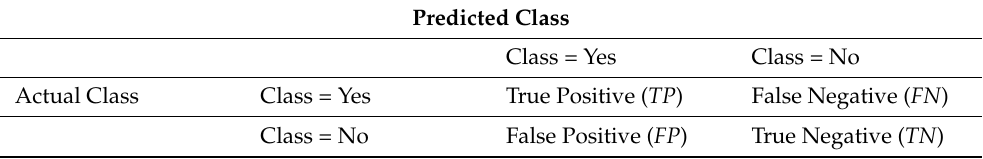
Table 1. The confusion